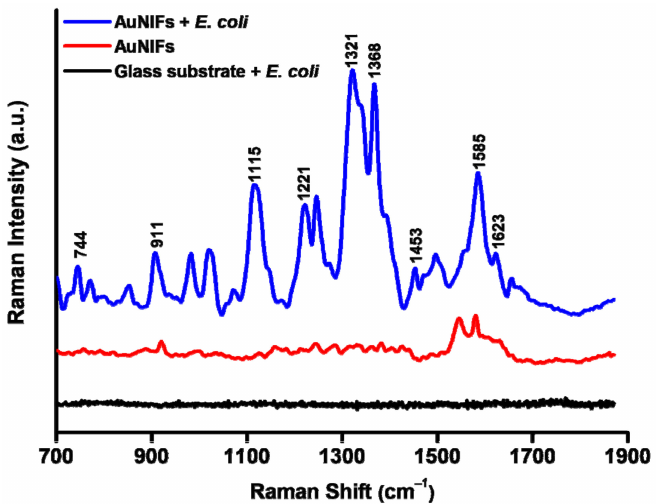
Figure 3. Raman spectra of the glass substrate cultured with Escherichia coli (black line), the gold nanoisland film (AuNIF) without E. coli (red line), and the AuNIF cultured with E. coli (blue